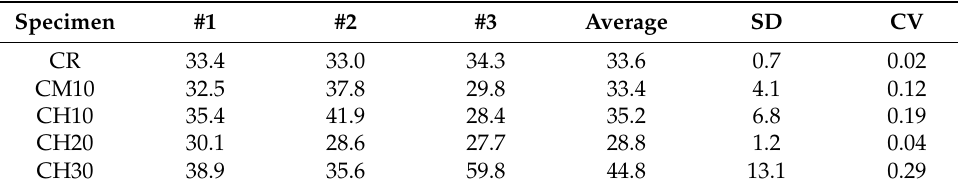
Table 4. Results of compressive strength test of masonry prism.